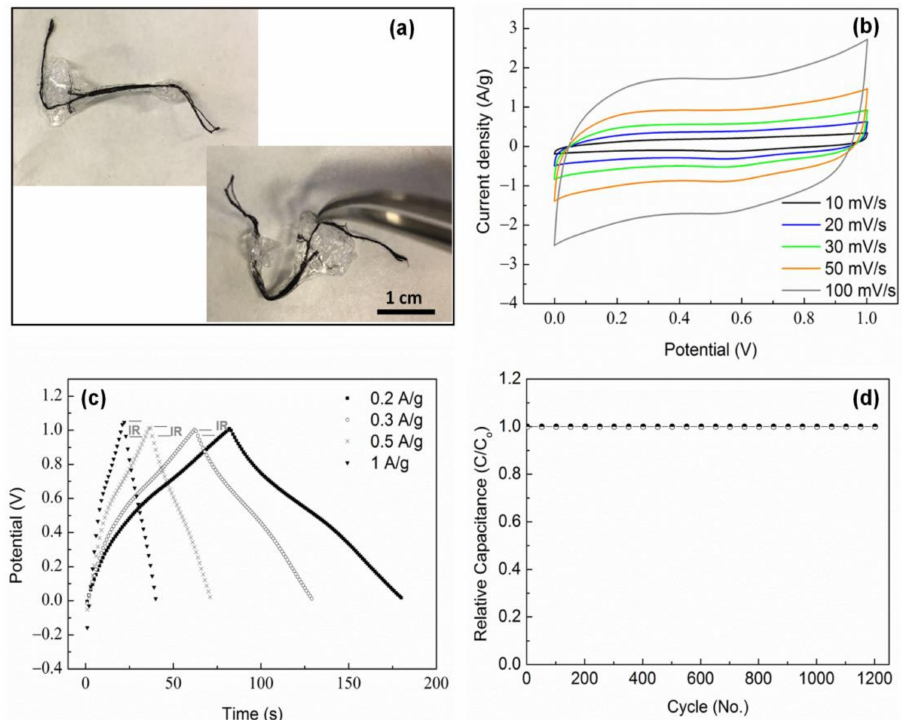
Figure 9. Electrochemical characterization of the symmetric CNT–MnO 2 fiber supercapacitor using PVA/H 3 PO 4 polymer as the solid electrolyte: ( a ) photograph showing the flexibility of the wire-shaped supercapacitor, ( b ) CV curves of the CNT– MnO 2 fiber supercapacitor at various scan rates, ( c ) CP curves at different current densities, and ( d ) cycling performance of the supercapacitor at a current density of 1 A/g.